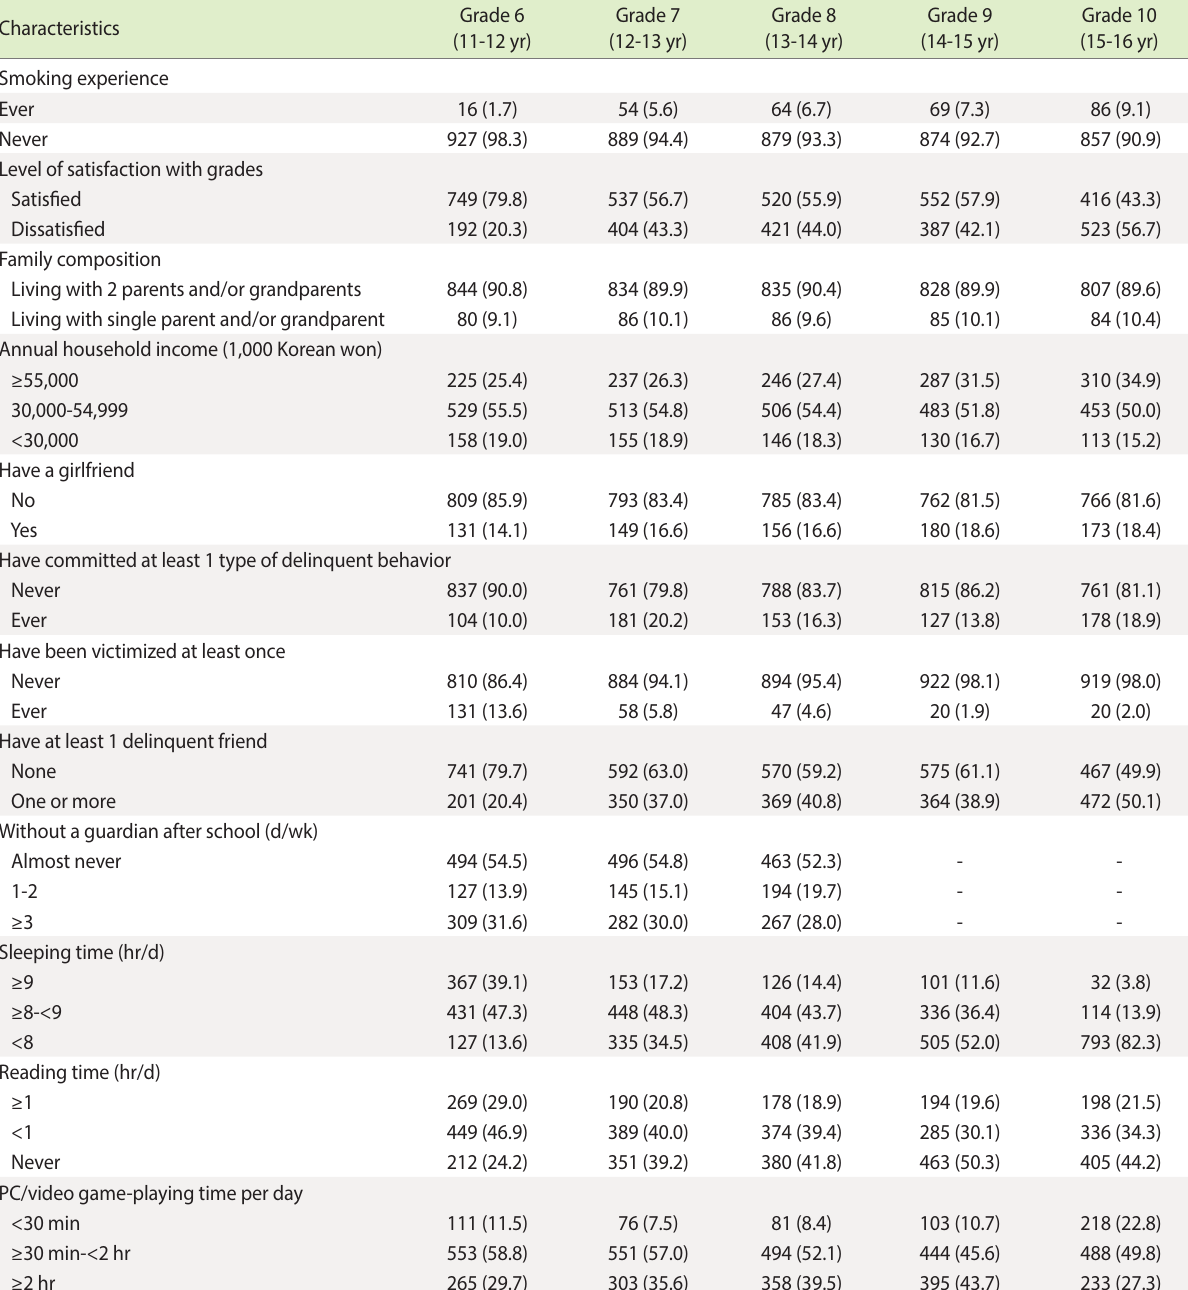
Table 1. Characteristics of study participants by grade